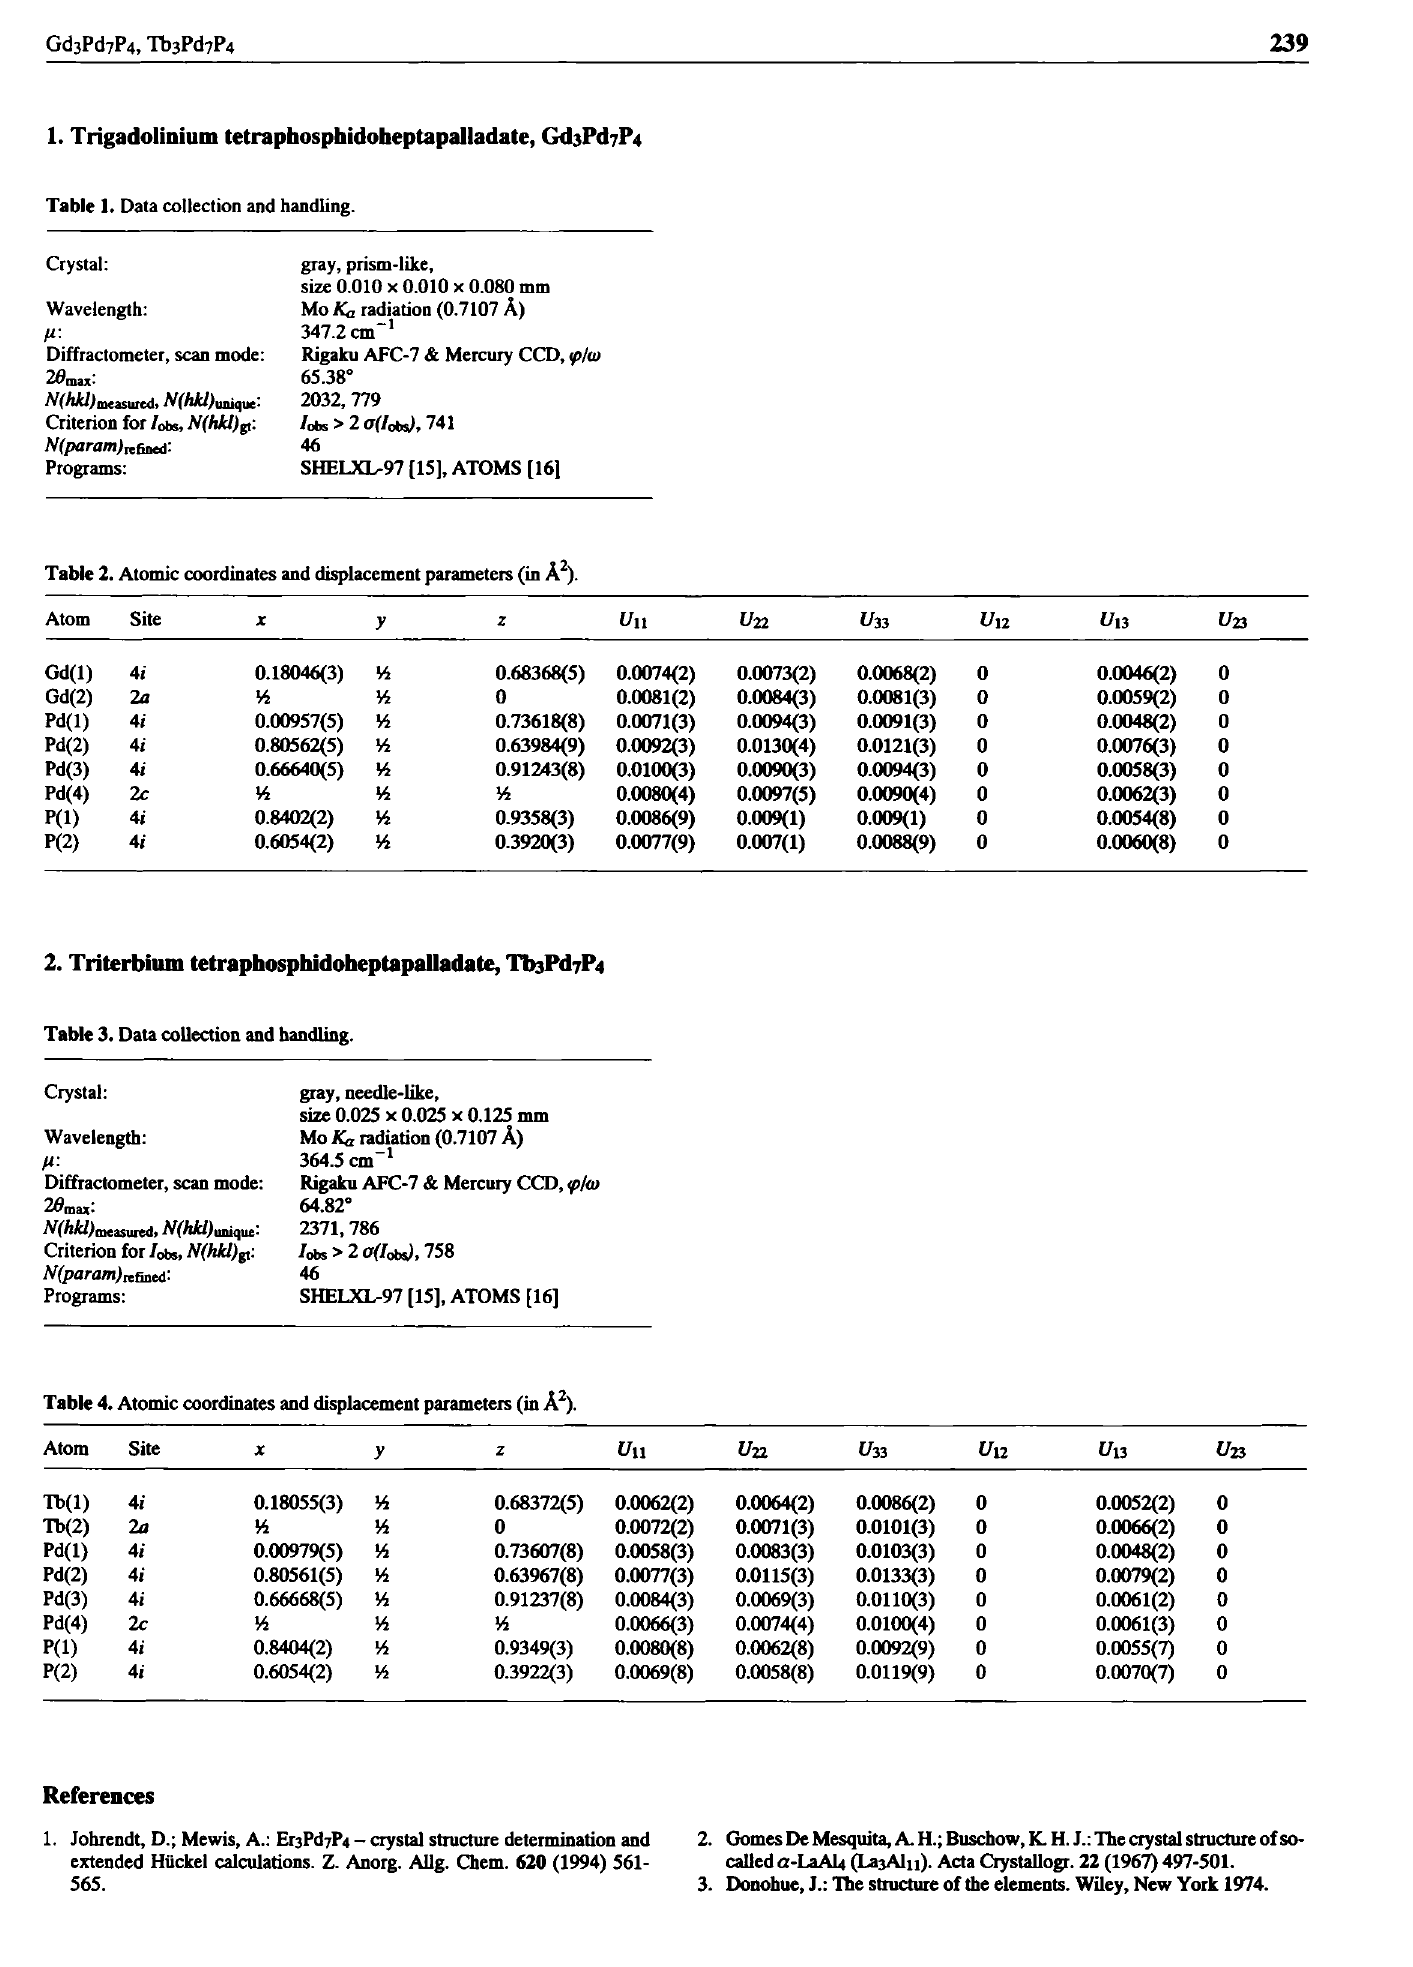
Table 1. Data collection and handling.